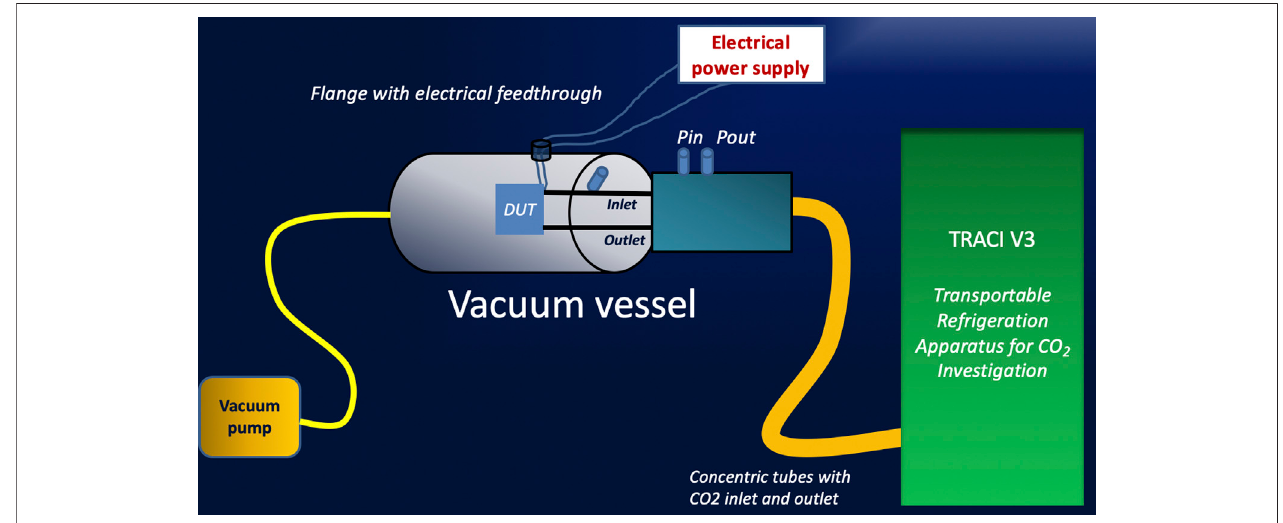
FIGURE4| Sketchofthe refrigeration systemused totest thevertically integratedmodule.Avacuumpumped vessel isused tohostthemoduleand isconnected to TRACI with CO 2 inlet and outlet tubes. A fl ange with electrical feedthroughs allows the applications of bias voltages and the extraction of electrical signals from the vessel.